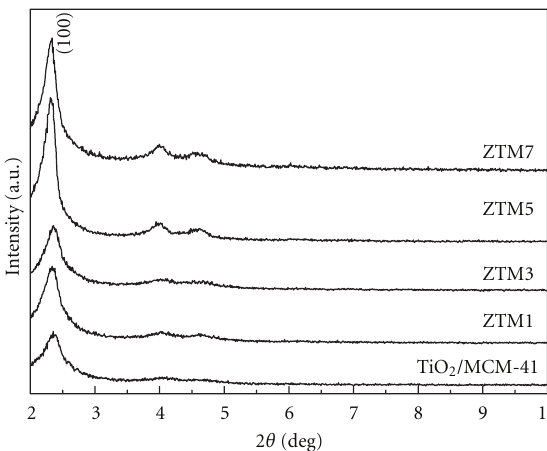
Figure 4: SAXRD patterns of TiO 2 /MCM-41 and ZTM series